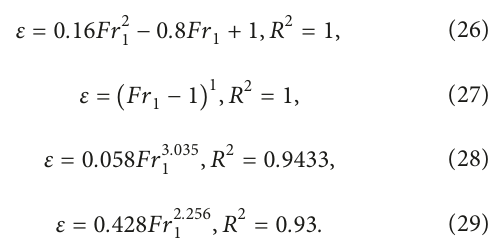
Figure 10: Measured and computed values of ∆ E/ E (15)).